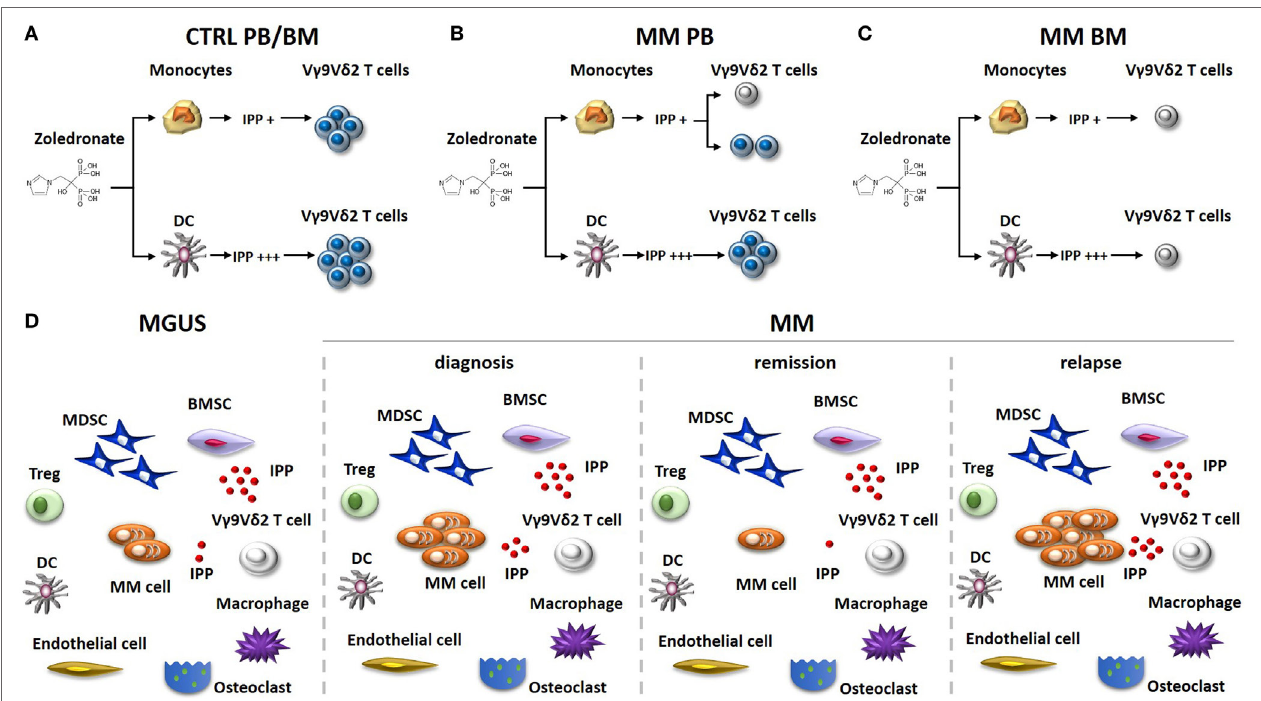
FigURe 1 | V γ 9V δ 2 T-cell impairment in the immune suppressive TME of MM patients. The stimulation of monocytes or DC with zoledronate (ZA) and low dose of IL-2 is commonly used in vitro to induce IPP-dependent V γ 9V δ 2 T-cell activation. (A) This approach is uniformly effective in healthy donors (Ctrl), no matter whether V γ 9V δ 2 T cells are from the PB or the BM. ZA-treated DC are more effective than ZA-treated monocytes to induce V γ 9V δ 2 T-cell activation because they produce higher IPP amounts. (B) PB V γ 9V δ 2 T cells are refractory to ZA stimulation (gray colored) in about 50% of MM patients at diagnosis, when monocytes are used as stimulators. Anergy in these patients can be recovered if ZA-treated DC instead of monocytes are used as stimulators. (C) BM V γ 9V δ 2 T cells from MM patients are uniformly anergic to ZA stimulation and the anergy is not corrected by ZA-treated DC. (D) The immune suppressive TME of MGUS and MM patients includes suppressor cells like Tregs, MDSC, and BMSC (that produce high amounts of IPP). The proportion of these cells is very similar irrespective of the disease status. MDCS are PD-L1 + in MGUS and MM irrespective of the disease status and release high amounts of IPP in the TME. Other cells playing a major role in the TME are macrophages, endothelial cells, and osteoclasts. The proportion of these cells is variable according to diagnosis and disease status. The defective pAg reactivity of V γ 9V δ 2 T-cell (gray colored) is present in MGUS, MM at diagnosis, MM in remission, and MM in relapse. Elimination of myeloma cells (that are PD-L1 + and release IPP) is insufficient in the short/intermediate term to recover V γ 9V δ 2 T-cell functions. It is possible that the persistence of PD-L1 + cells in the TME (i.e., MDSC), high levels of extracellular IPP, and PD-1 expression (and other ICP) on their cell surface continue to render functionally incompetent BM V γ 9V δ 2 T cells even in the remission phase. Abbreviations: DC, dendritic cells; ZA, zoledronate; IPP, isopentenyl pyrophosphate; PB, peripheral blood; BM, bone marrow; Ctrl, healthy subjects; MM, multiple myeloma; Tregs, regulatory T cells; MDSC, myeloid-derived suppressor cells; BMSC, bone marrow-derived stromal cells; MGUS, monoclonal gammopathy of undetermined significance; TME, tumor microenvironment; ICP, immune checkpoint; PD-1, programmed cell death protein